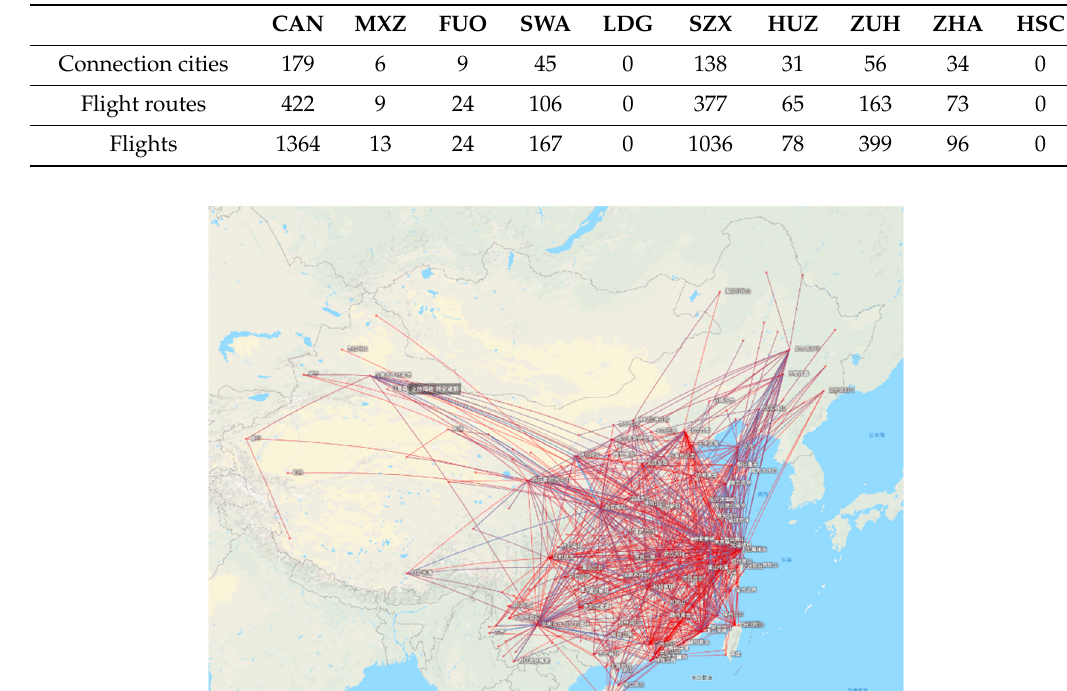
Figure 11. Flight lines in China on June 25, 2019 (https://www.flightaware.com).